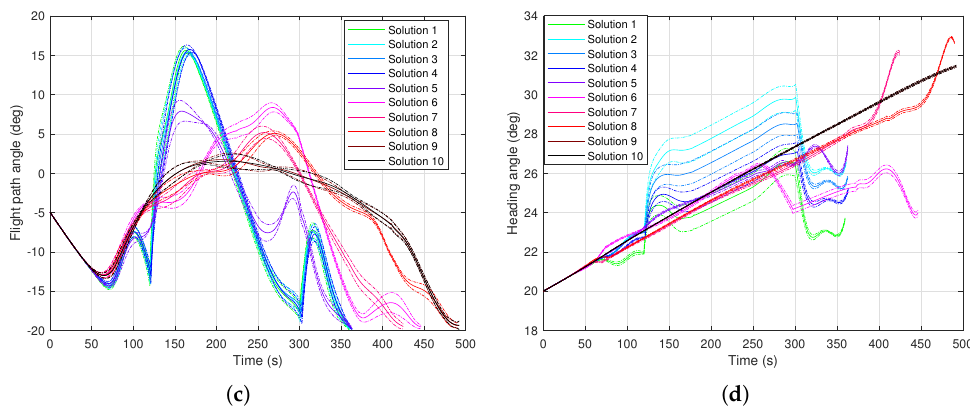
Figure 5. State variables for set of 10 Pareto-optimal solutions, with dashed and dotted lines showing ± 1 σ uncertainty. ( a ) Altitude; ( b ) Magnitude of the velocity; ( c ) Flight path angle; ( d ) Heading angle.